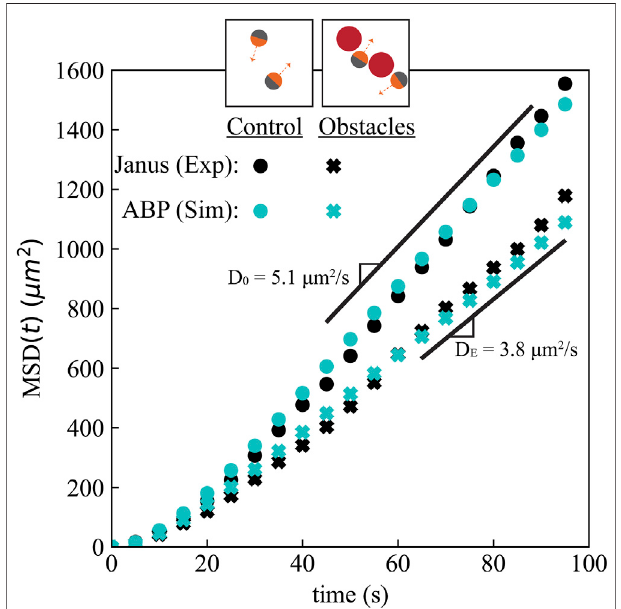
FIGURE 2 | The effective diffusivity of active particles decreased by 25 % in a random array of fi xed obstacles at ϕ ≈ 12 % area fraction. The mean squared displacement (MSD) of 4 μ m active Janus colloids in experiments (black symbols) agrees with that in our BD simulation of the equivalent system using the active Brownian particle (ABP) model (cyan symbols), for both the control case without obstacles (circles) and with a random distribution of 6.5 μ m obstacles (cross marks). Labelled diffusivities correspond to the fi t to the slope at times past 50 s in the experiments. Standard error of the mean for the MSDs is available in the Supplementary Figure S2 . Additional MSD simulation data for different ABP activities is available in Supplementary Figure S3